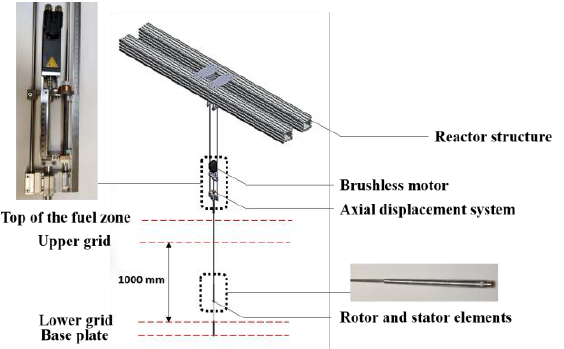
Figure 5. Schematic representation of the mechanical elements of PISTIL The mechanical concept of PISTIL included the possibility to modify the axial position of the rotor with respect to the stator over 100 mm range, while the rotor/stator ensemble can also be adjusted from 550 mm to 950 mm. This can be achieved when the device is installed inside the core.